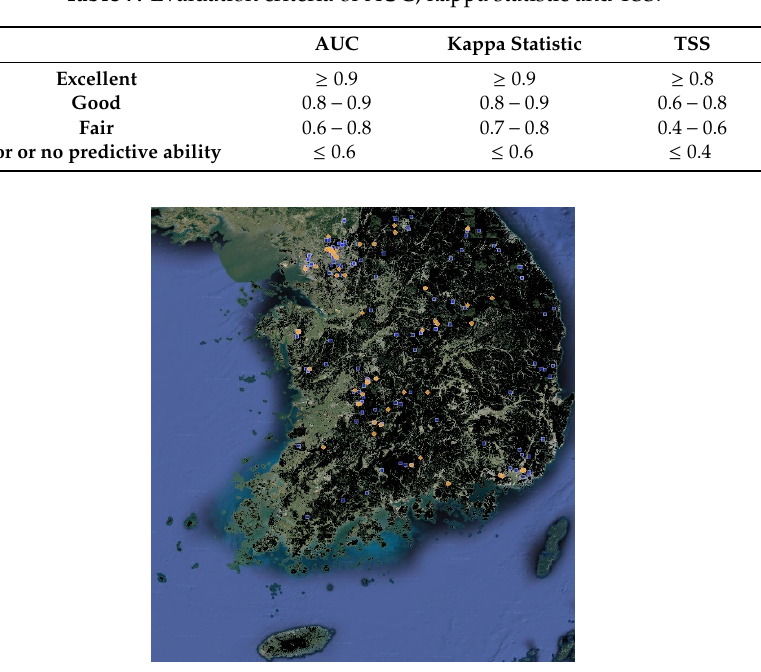
Table 7. Evaluation criteria of AUC, kappa statistic and TSS.